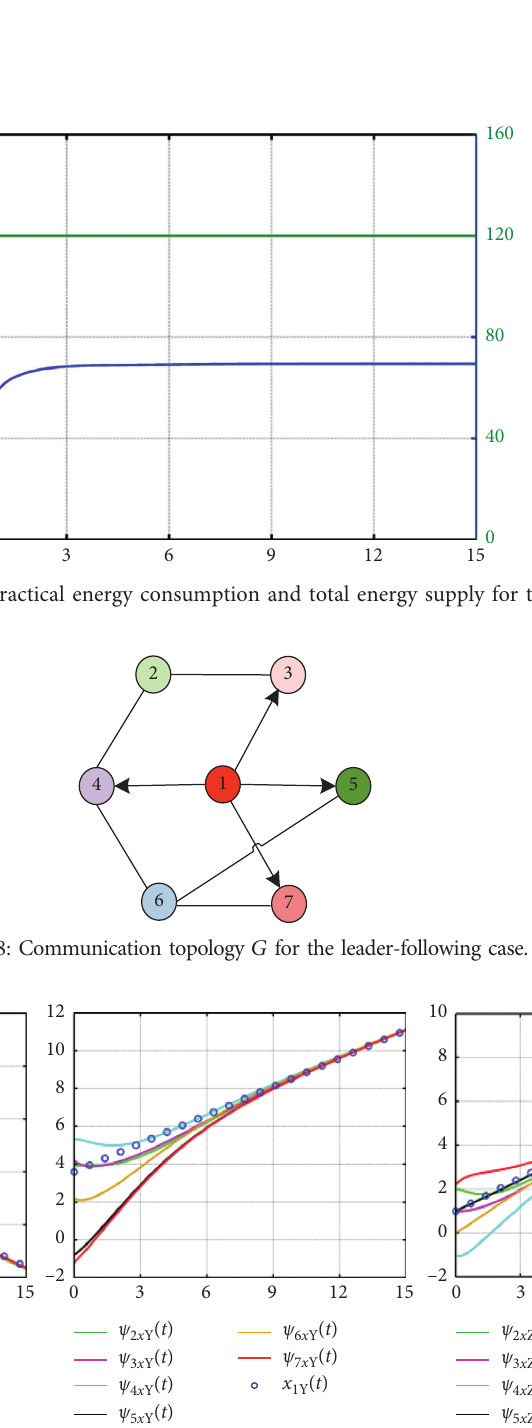
Figure 9: Trajectories of ψ